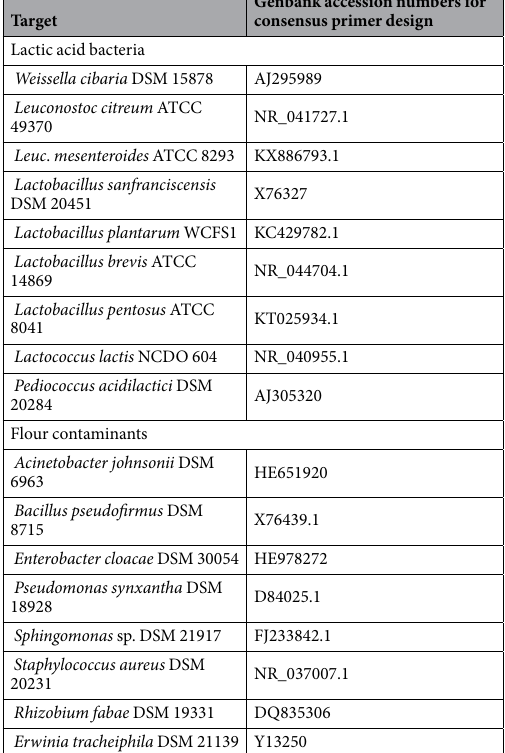
Table 1. List of lactic acid bacteria and main flour contaminants used for consensus primer